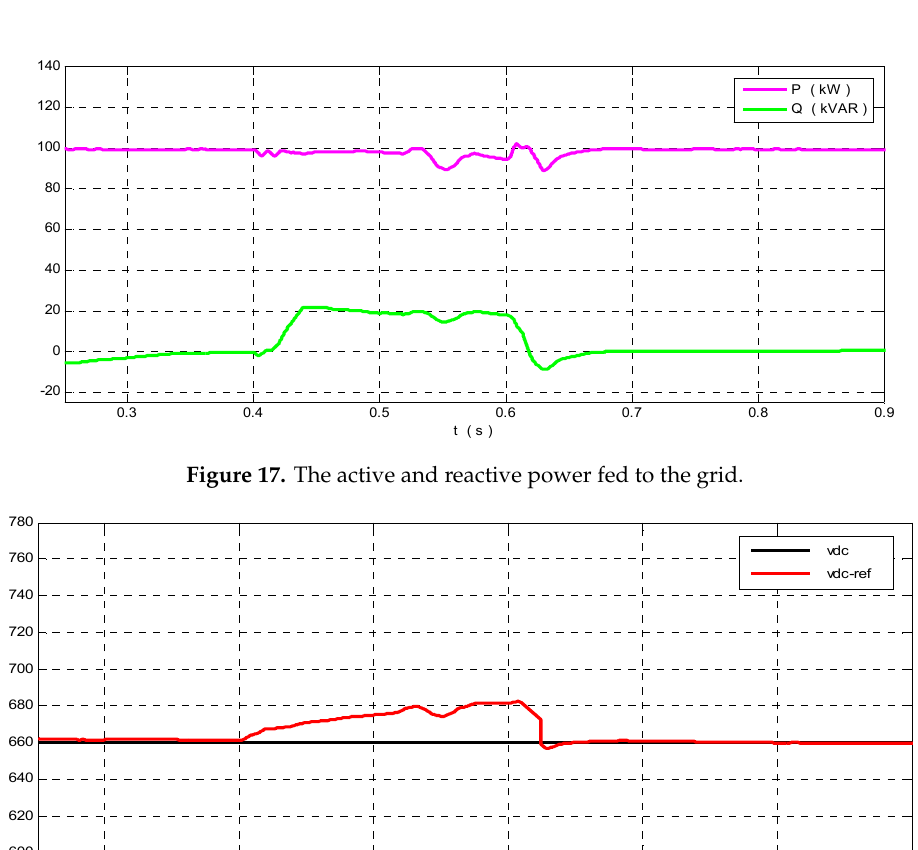
Figure 16. The result simulation of wt.